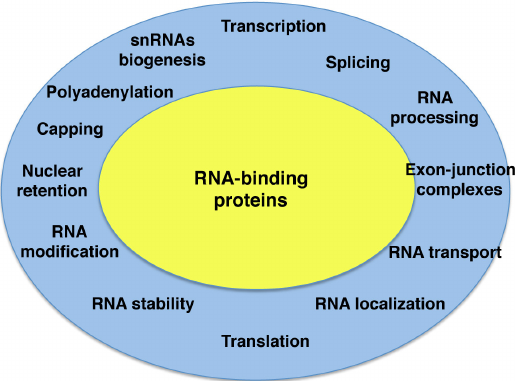
Figure 1. Gene expression control in eukaryotic cells. Each step of gene expression is controlled by RNA-binding proteins ( yellow ), such that altering one step affects the rest ( blue ring ) impacting on translation efficiency of mRNAs.